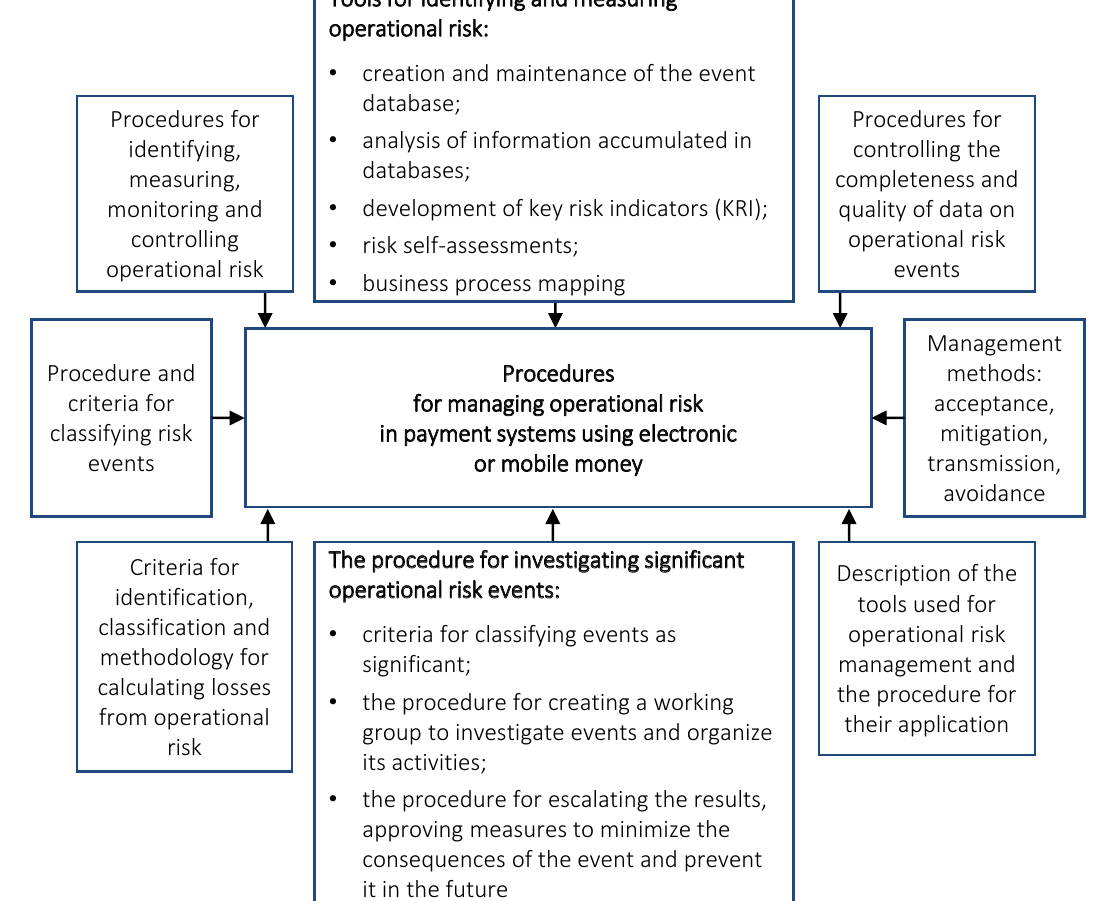
Figure 3. Scheme for organizing the operational risk management process in payment systems using electronic and mobile